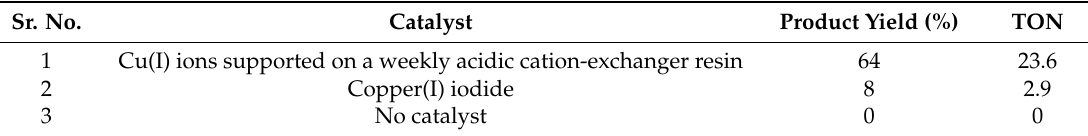
Table 1. Comparison of different catalytic conditions for C-N coupling of 4-methoxyaniline with